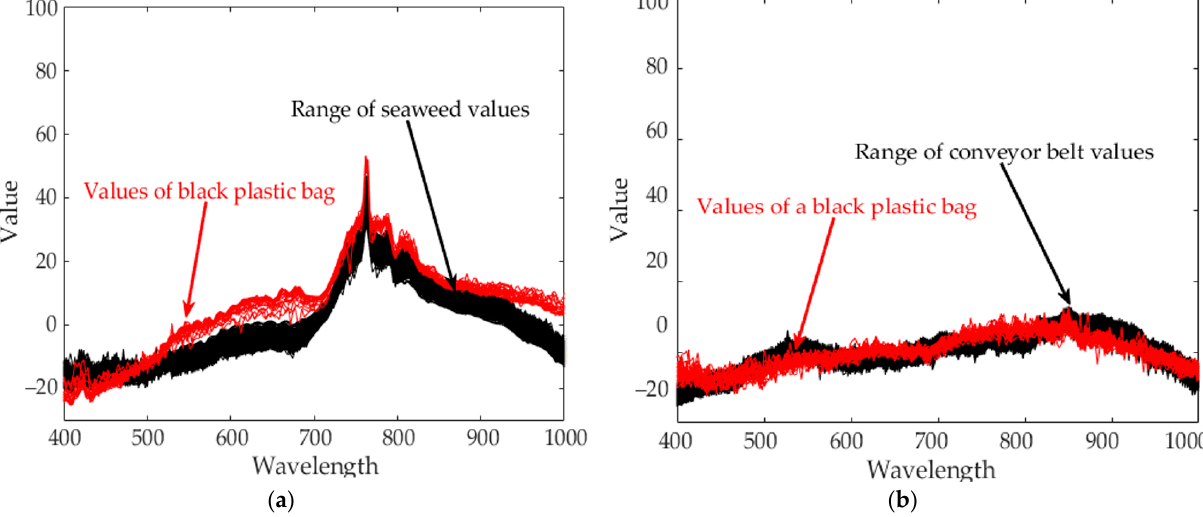
Figure 11. Flow chart of overall process. 3.2. Detection Results of MCSVM The multi-class support vector machine (MCSVM) used in the experiment is a three- class (Seaweed, conveyor belt, and foreign objects) classifier using a 112-dimensional SAM kernel. As an example, to test the performance of MCSVM, we used the same hyperspec- tral image used in the proposed algorithm. Both shrimp shells and black plastic bags were successfully detected. However, it can be seen from Figure 12a that many FP (False-Posi- tive) pixels have occurred.